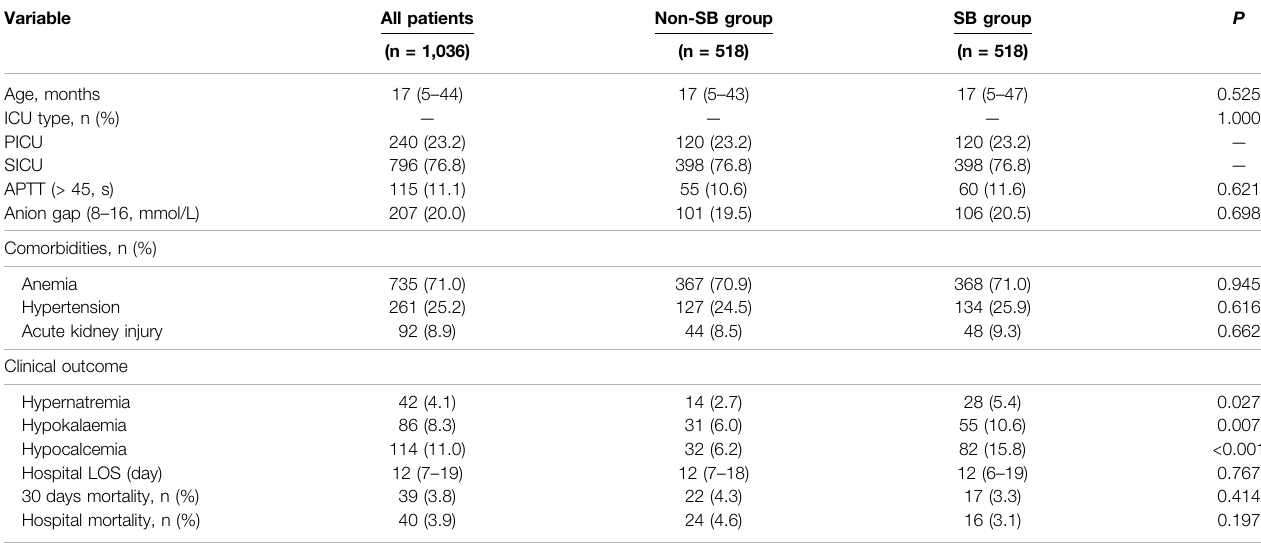
TABLE 4 | Comparisons of the covariates after propensity score matching. Variable All